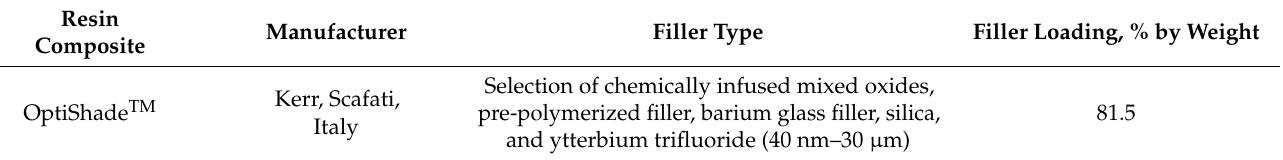
Table 1. Composition of the resin composite material used in this study.